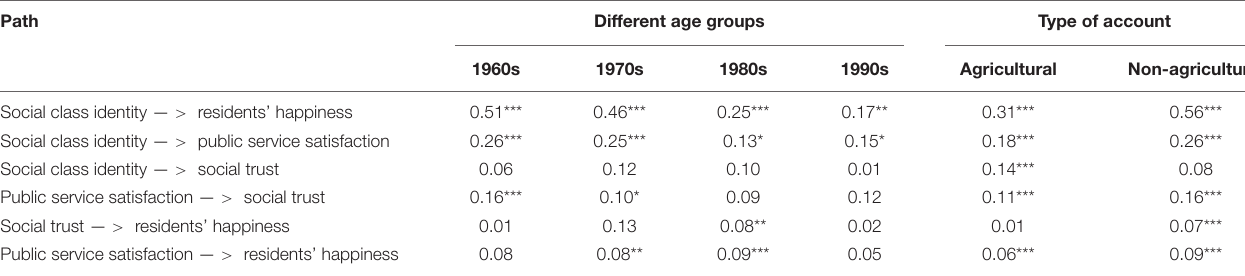
TABLE 8 | Comparison of path standardization coefficient between different